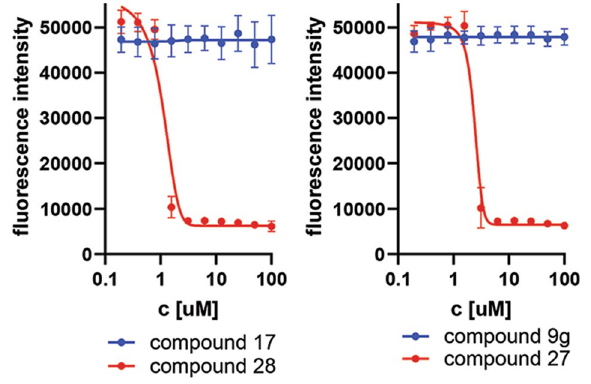
Figure 7. Alamar blue assay of BSF 427 cells treated with free ANPs (compound 17 and 9g ) and with their respective prodrugs (compound 28 and 27